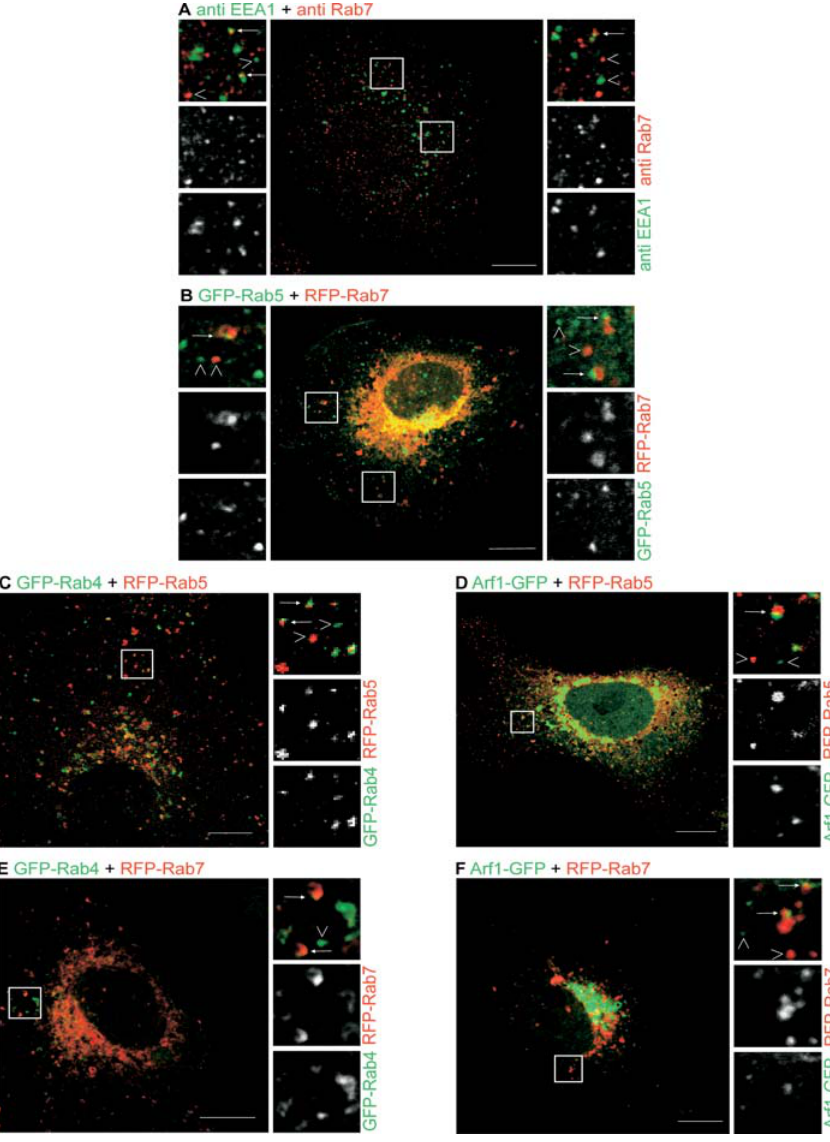
Figure 3. Endosomes Labeled with Two Markers Show Presence of Rab7 in Early Endosomes Vero cells were fixed and viewed by confocal microscopy. (A) Confocal microscopy of immunolabeled cells using anti-EEA1 (green) and anti-Rab7 (red) antibodies, (B–F) The cells were transfected with fluorescent-protein-labeled constructs as follows: (B) GFP-Rab5 and RFP-Rab7, (C) GFP-Rab4 and RFP-Rab5, (D) Arf1-GFP and RFP-Rab5, (E) GFP-Rab4 and RFP-Rab7, and (F) Arf1-GFP and RFP-Rab7. Arrowheads show individual endosomes positive for one of the two markers, and arrows indicate endosomes positive for two markers. Scale bars represent 10 l m. DOI: